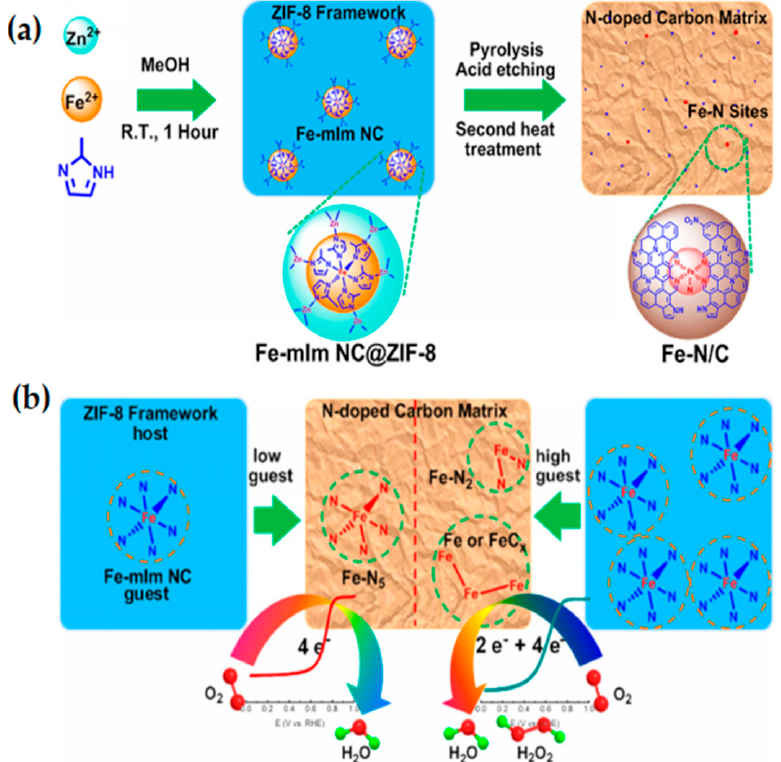
Figure 6. ( a ) Illustration of the host-guest chemistry strategy to fabricate MOF-derived Fe-N/C catalysts; ( b ) Schematic diagram of the formation of Fe-N x structures with different coordination numbers. Copyright 2017, American Chemical Society [80].